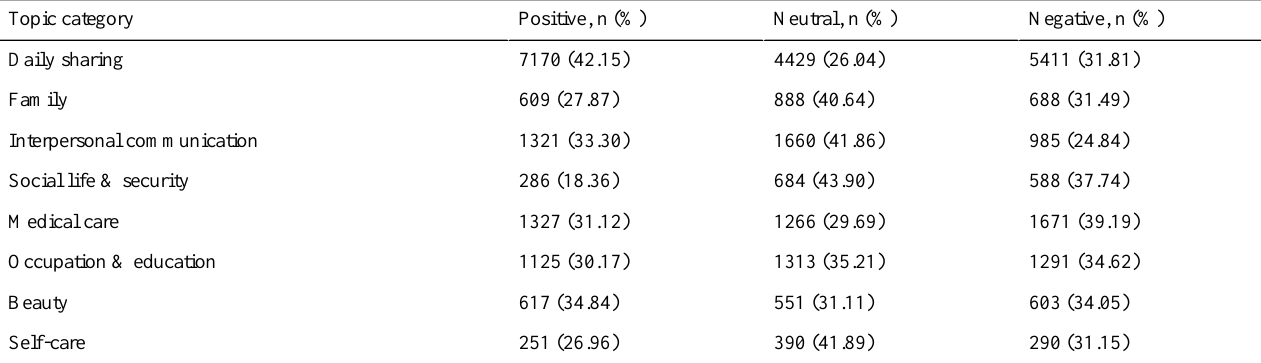
Table 4. Results of the sentiment polarity analysis results for the 8 topic